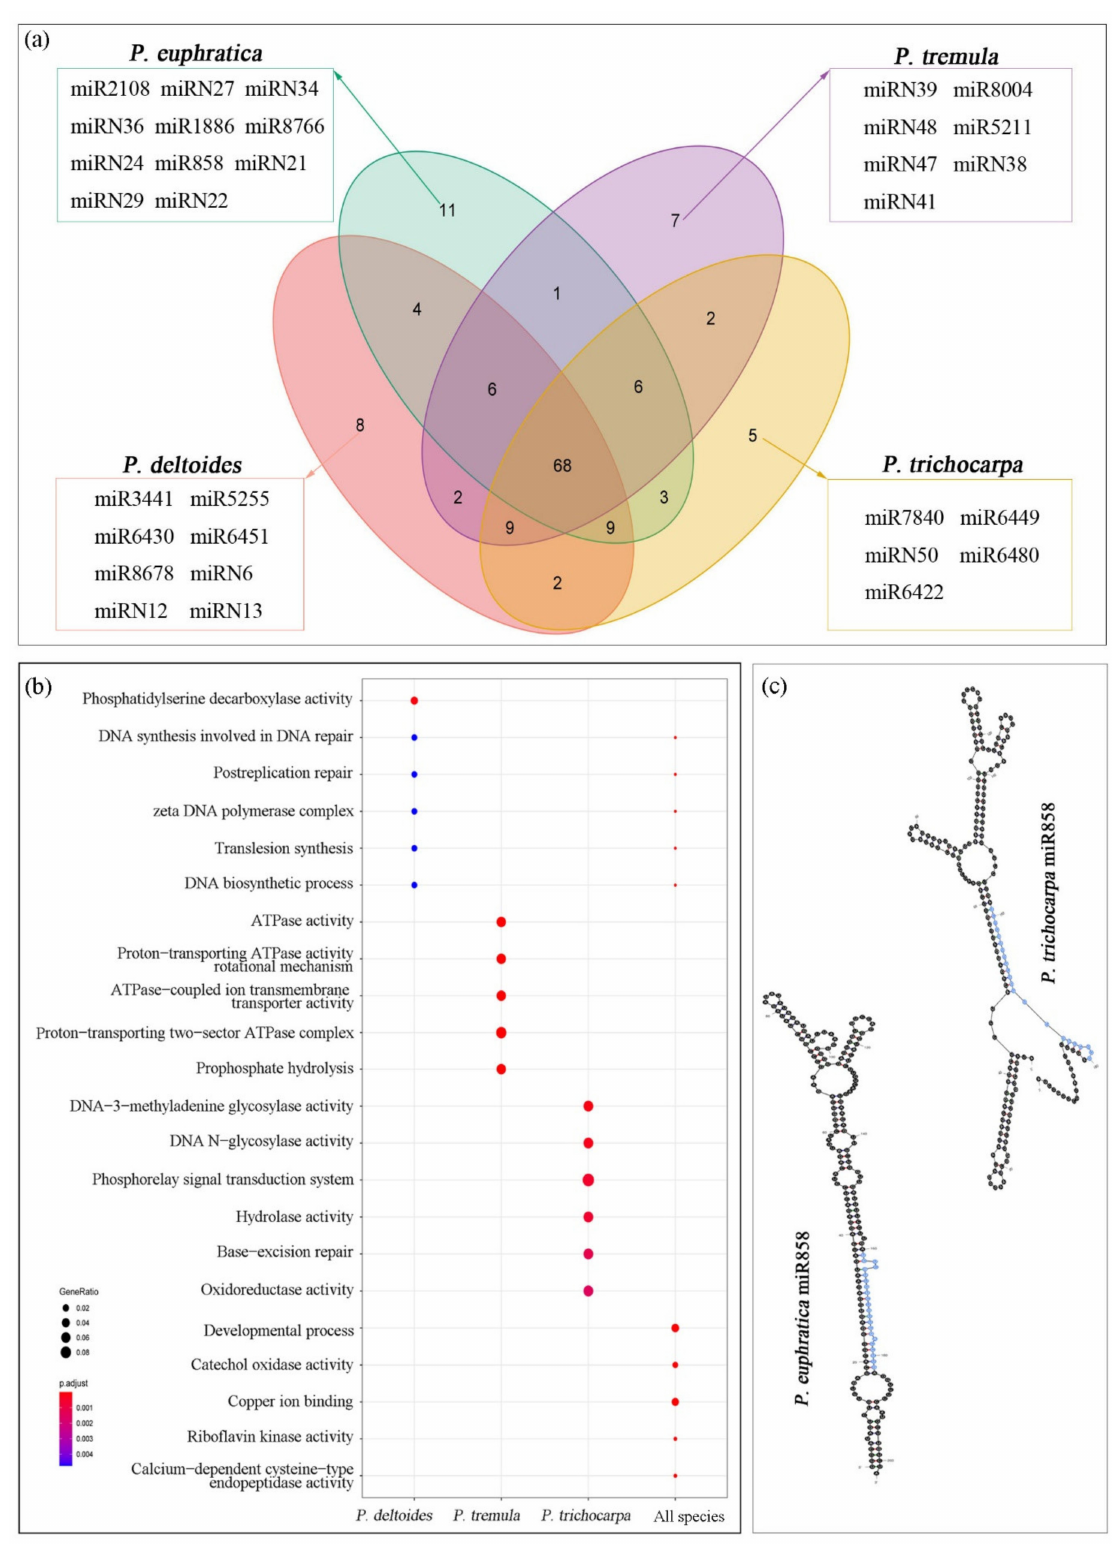
Figure 4. Comparative analysis of miRNA families among four poplar species ( a ). GO enrichment analysis of miRNAs specific to P. deltoides , P. tremula , and P. trichocarpa and miRNAs shared by the four species ( b ). Pre-miR858 secondary structure of P. euphratica and P. trichocarpa ( c